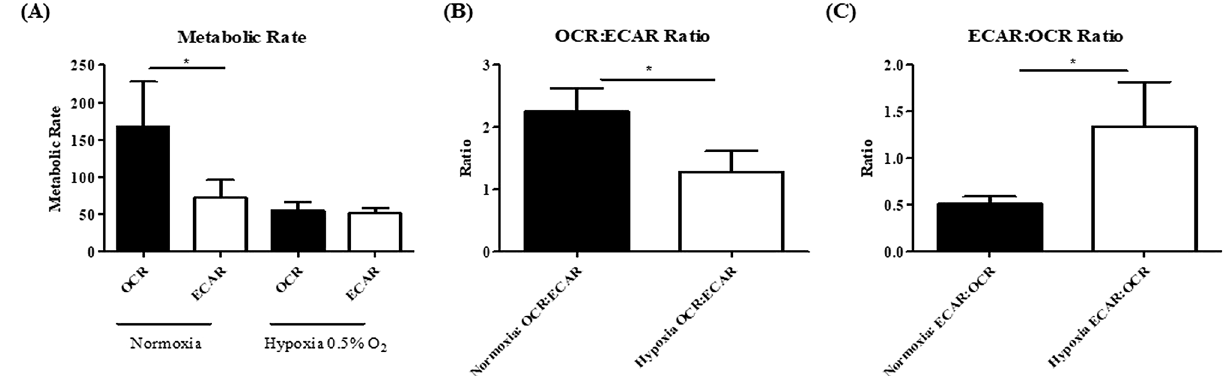
Figure 3. OAC treatment-naïve patient biopsies have an altered metabolic phenotype under hypoxic conditions (0.5% O 2 ). OCR and ECAR were measured in real-time in male OAC treatment biopsies using Seahorse Technology. ( A ) Basal OCR and ECAR at baseline and post 6 h incubation under hypoxia 0.5% O 2 , (n = 7). ( B ) OCR:ECAR ratio of OAC pre-treatment biopsies cultured under normoxic and then hypoxic conditions, (n = 7). ( C ) ECAR:OCR ratio of OAC treatment-naïve biopsies cultured under normoxic and then hypoxic conditions, (n = 7). Wilcoxon signed rank t-test, * p < 0.05. Data expressed as +